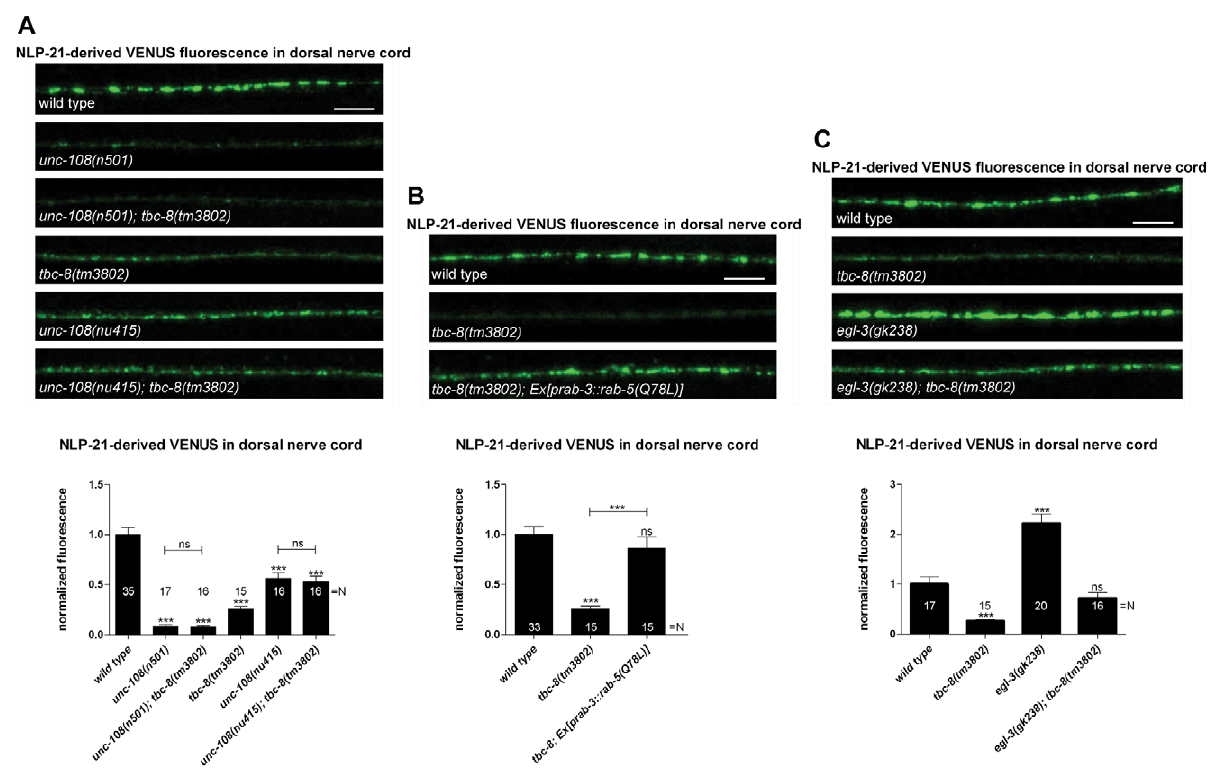
Figure 2. TBC-8 is involved in the same pathway as UNC-108/RAB-2. (A) Double mutants of tbc-8(tm3802) and dominant active unc-108/rab- 2(n501) or null allele unc-108/rab-2(nu415) , respectively, followed the phenotype of the unc-108/rab-2 single mutants. (B) Interfering with the endosomal/lysosomal pathway by overexpression of constitutively GTP-bound RAB-5 (Q78L) in a tbc-8(tm3802) mutant background restored the NLP- 21-derived VENUS fluorescence at the DNC back to wild type level. (C) TBC-8 is not involved in the generation of active NLP-21 neuropeptides. The double mutant egl-3(gk238); tbc-8(tm3802) restored NLP-21-derived VENUS cargo in the DNC back to wild type levels. Scale bar represents 5 m m. Error bars=s.e.m. (***, P , 0.0001; Student’s